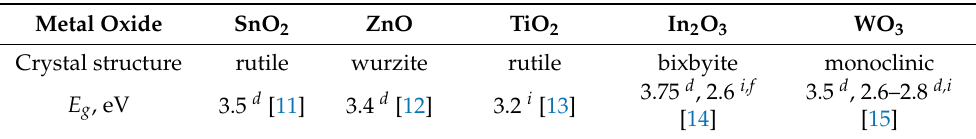
Table 1. Band gap ( E g ) values for metal oxides ( d —for direct allow transitions, i —for indirect allow transitions, f —for direct forbidden